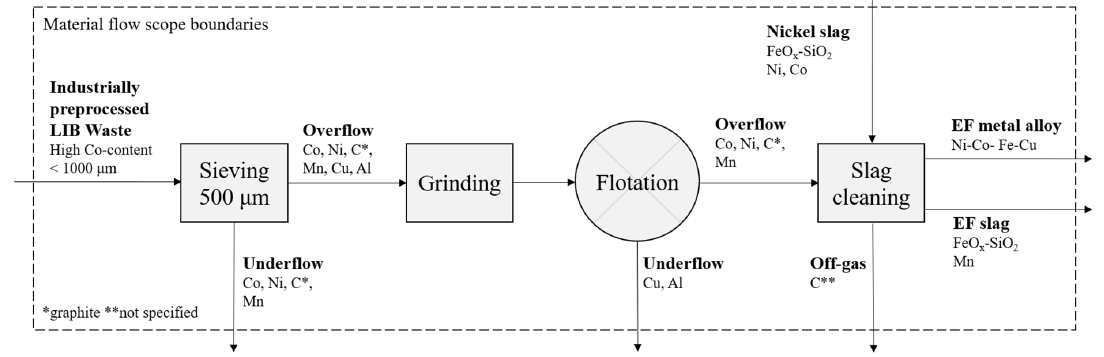
Figure 1. A simplified flowchart of the investigated LIBs recycling process. * graphite, ** not